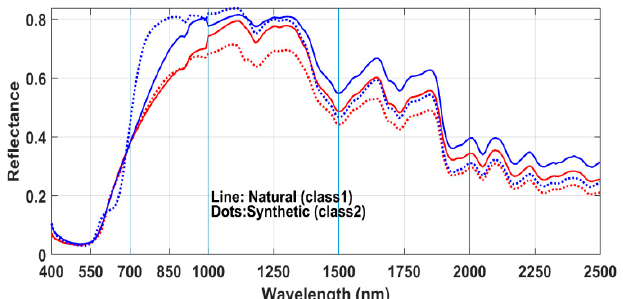
Figure 6. Average reflectance spectra of several patches with Red hue of natural and synthetic class both from set-1 and Set-2.